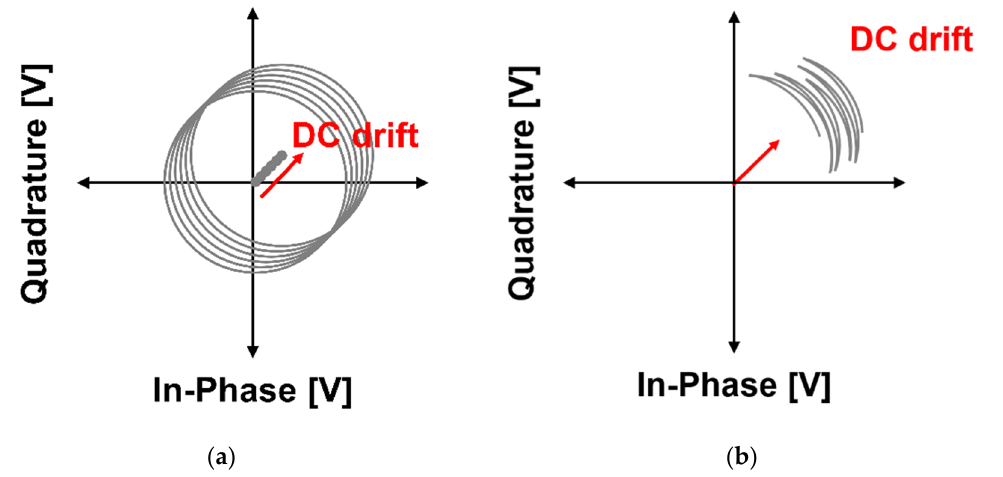
Figure 1. DC drift of the baseband I/Q signals in the complex plane: ( a ) when the displacement x ( t ) is sufficiently longer than the wavelength of the transmitting signals in the radar; ( b ) when x ( t ) is shorter than the wavelength.